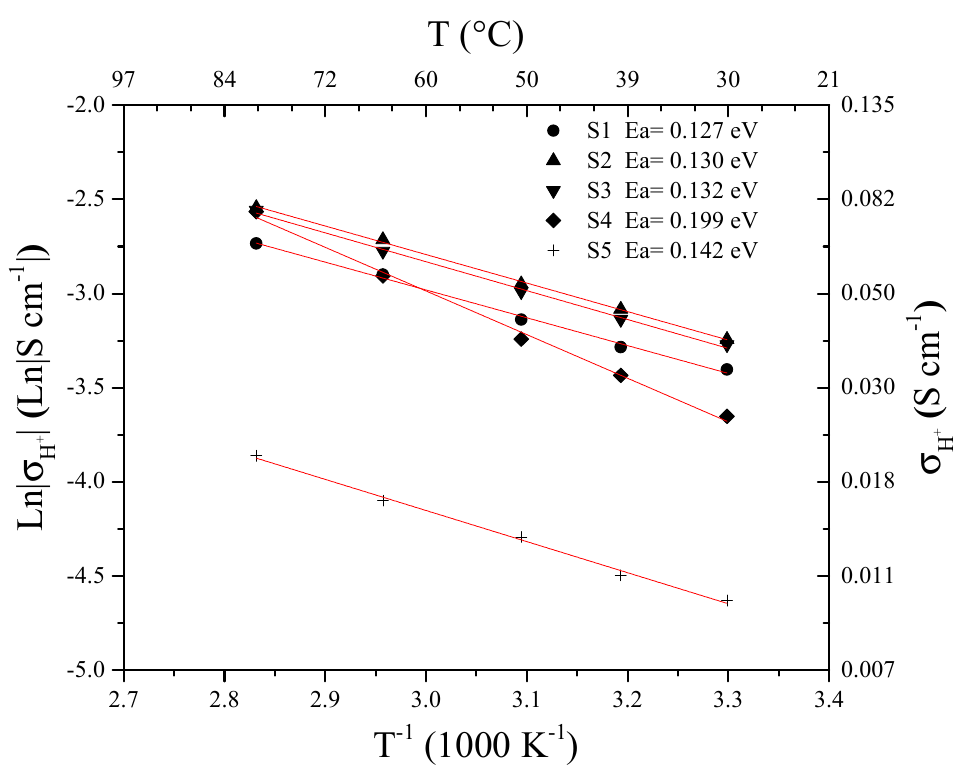
Figure 4. Arrhenius plot of proton conductivity as a function of temperature. Table 3. Activation energies and pre-exponential factor for proton conduction from Arrhenius plots.